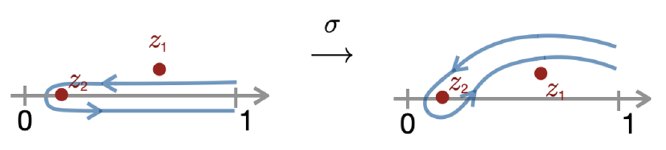
Figure 2 . Contour decomposition of the coproduct (cid:1) E i .